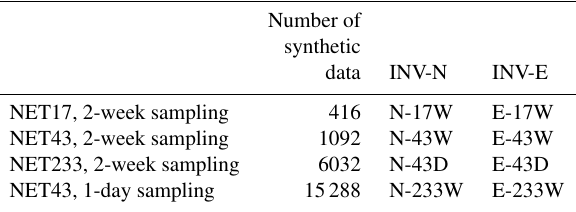
Number of synthetic data